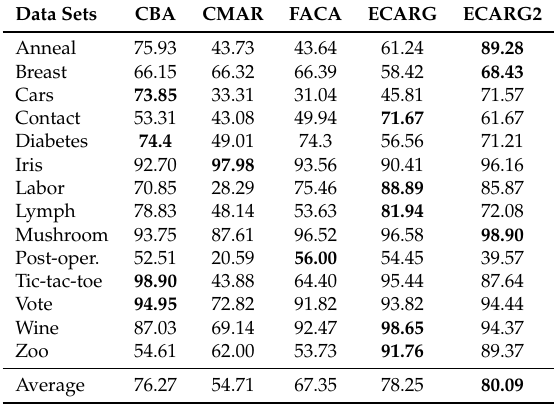
Table 14. F-measure of Classification-based Association (CBA), Classification based on